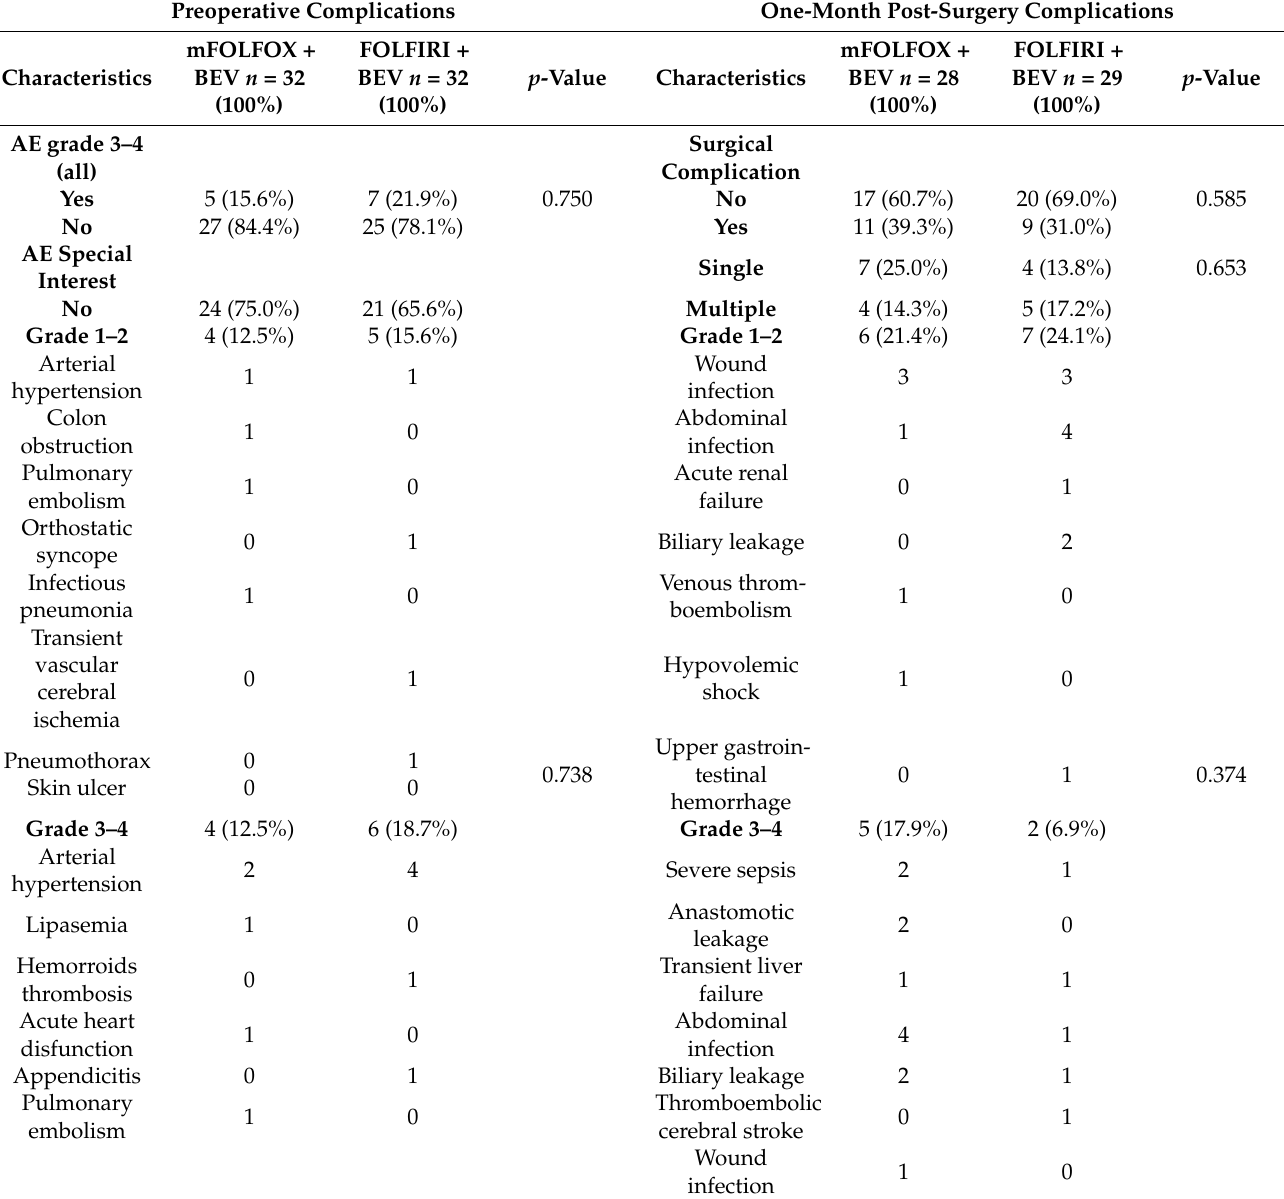
Table 2. Preoperative and one-month post surgery